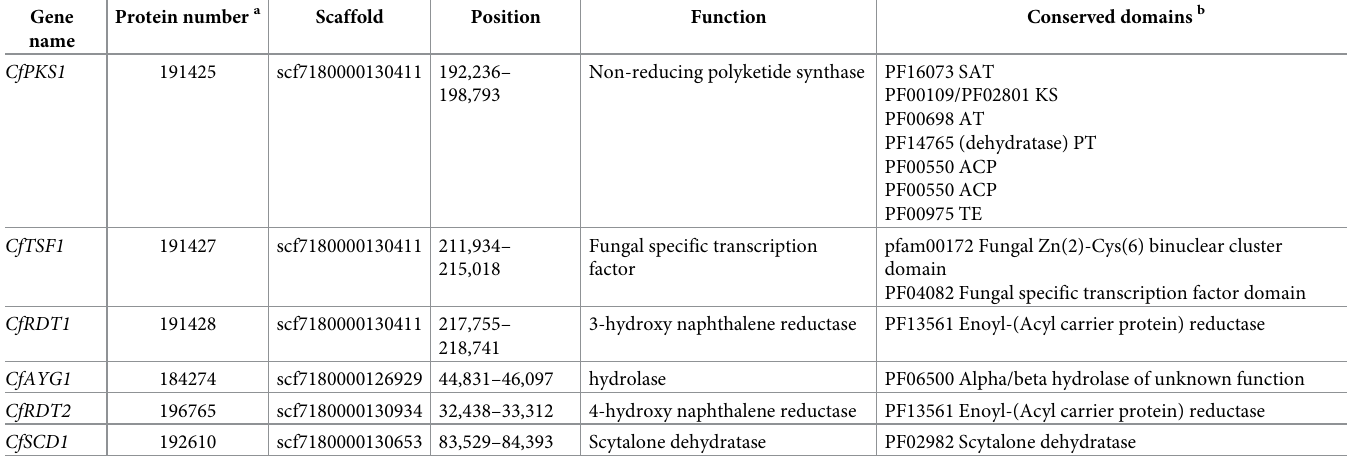
Table 1. List of Cladosporium fulvum genes that are orthologous to melanogenic genes in other fungi.